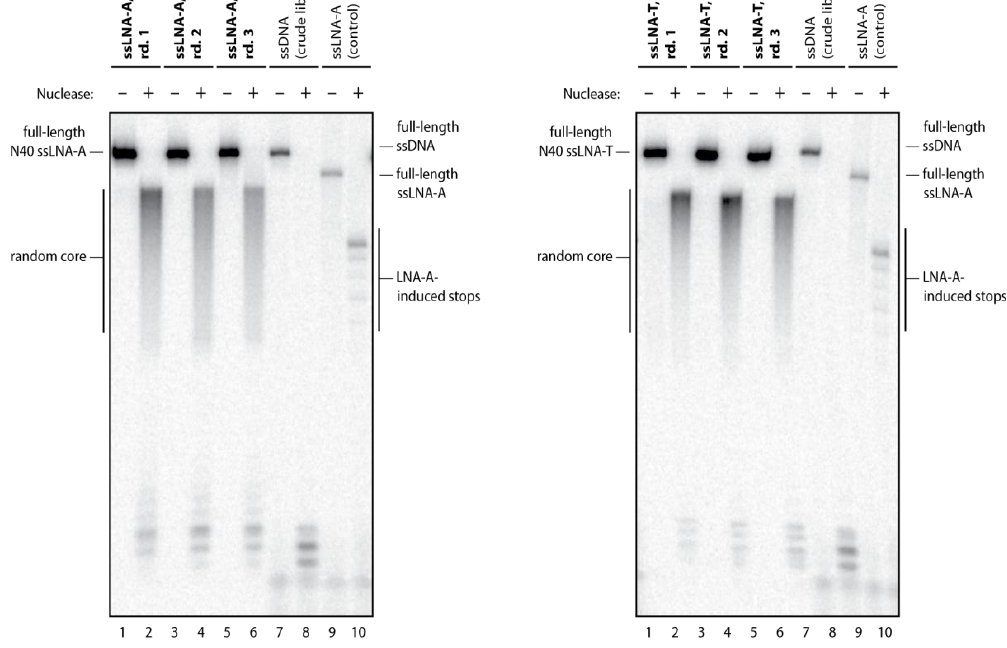
Figure 2. ( Left ) Exonuclease digestion of the LNA-A containing library after 1, 2, and 3 rounds of mock in vitro selection (lanes 1–6). In the presence of exonuclease (+), the 3' end is readily degraded, while the LNA-containing random core is partially protected. The crude all-DNA library is readily degraded (lanes 7,8). A DNA oligomer with LNA-A at defined positions results in a step-wise degradation pattern (lane 9, 10). ( Right ) As in the left panel, but with exonuclease digestion of the LNA-T containing library after 1, 2, and 3 rounds of mock in vitro selection (lanes 1–6).